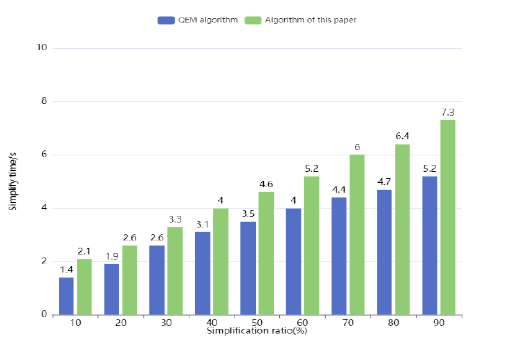
Figure 7 . Comparison of simplification time of different